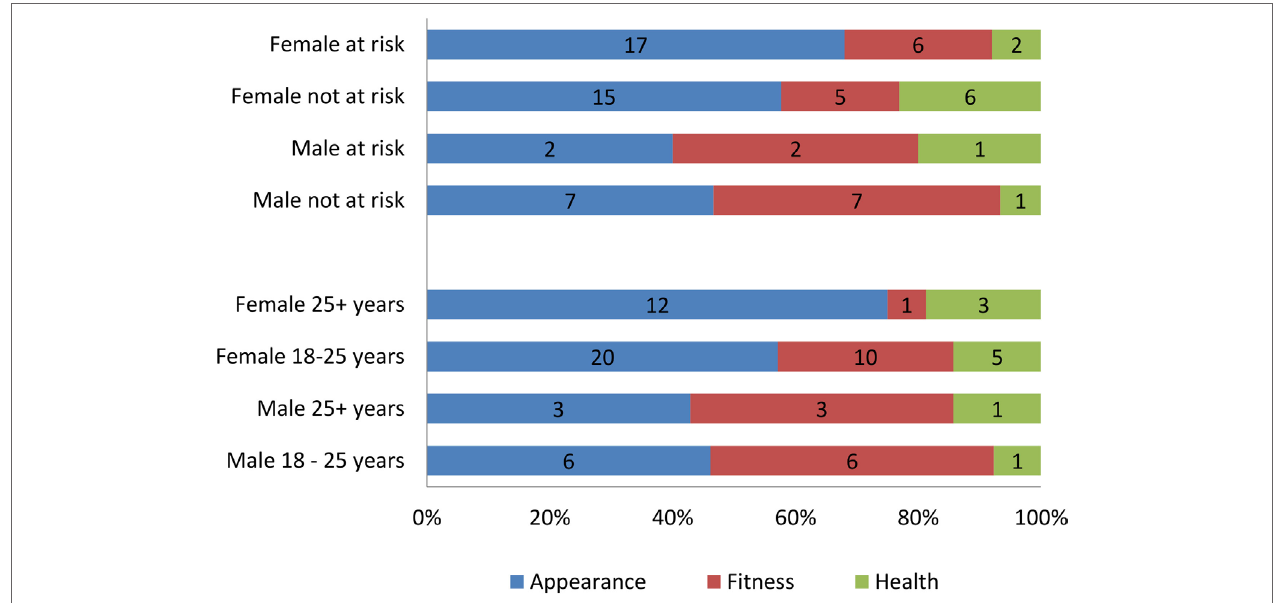
FigUre 6 | The main reason for wanting to lose weight in the stratified sample by age, gender, and at risk for developing eating